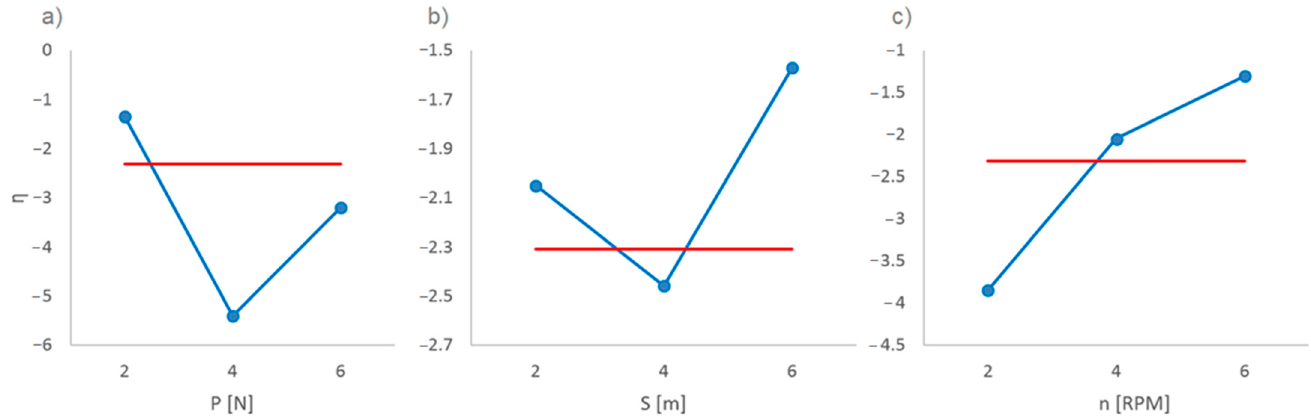
Figure 4. Dependence of the η parameter on: ( a ) load P , ( b ) friction distance S , and ( c ) counter-rotational speed n .